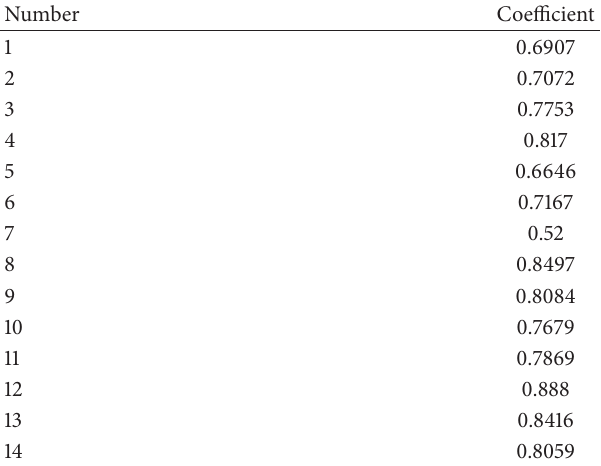
Table 5: Comprehensive evaluation coefficient.